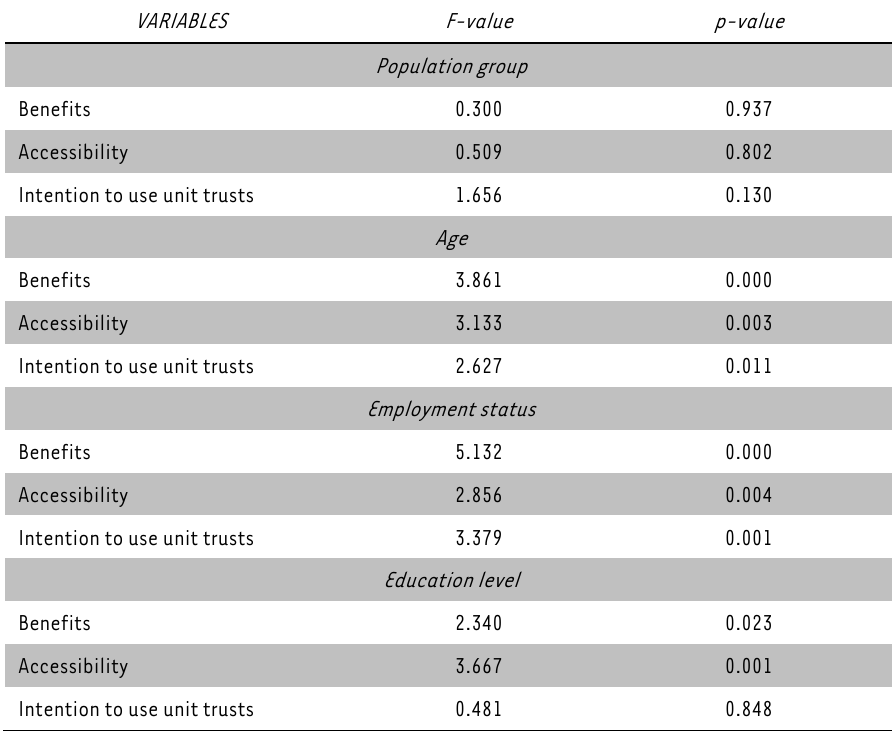
TABLE 7: Summary of ANOVA results of various categorical data on the independent and